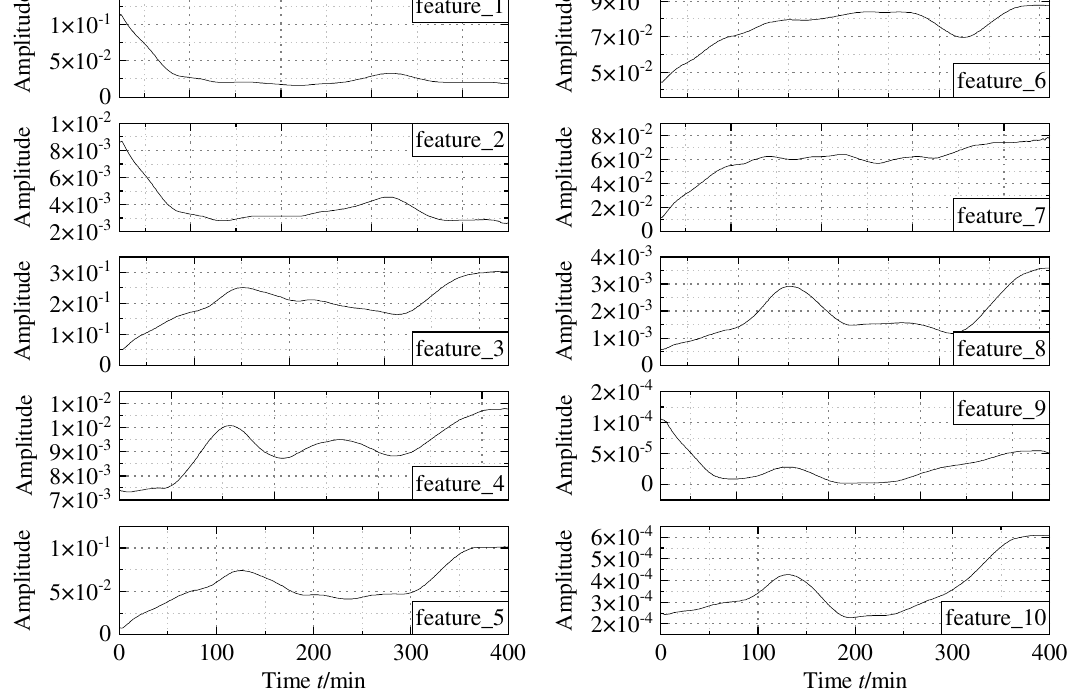
Figure 16. Curves of the first 10 characteristics after smoothing.